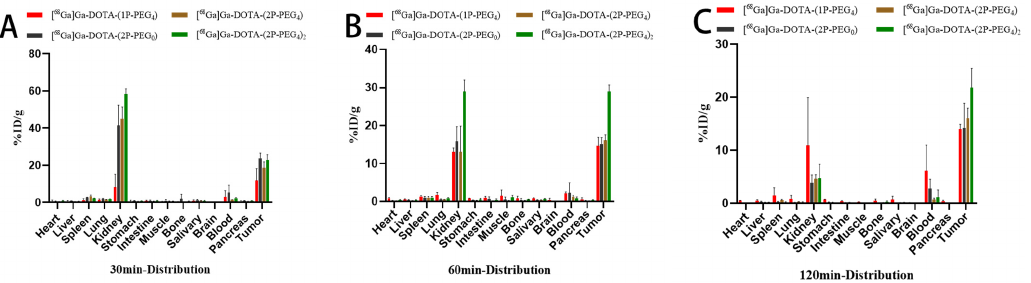
Figure 5. PC-3 PIP tumor-bearing mice were intravenously injected with 68 Ga-labeled DOTA-(1P- PEG 4 ), DOTA-(2P-PEG 0 ), DOTA-(2P-PEG 4 ), and DOTA-(2P-PEG 4 ) 2 at a dosage of 70 µCi through the caudal vein, and the corresponding tissue uptake values at 30 min ( A ), 60 min ( B ) and 120 min ( C ) were detected and presented as mean ± SD, n = 3.